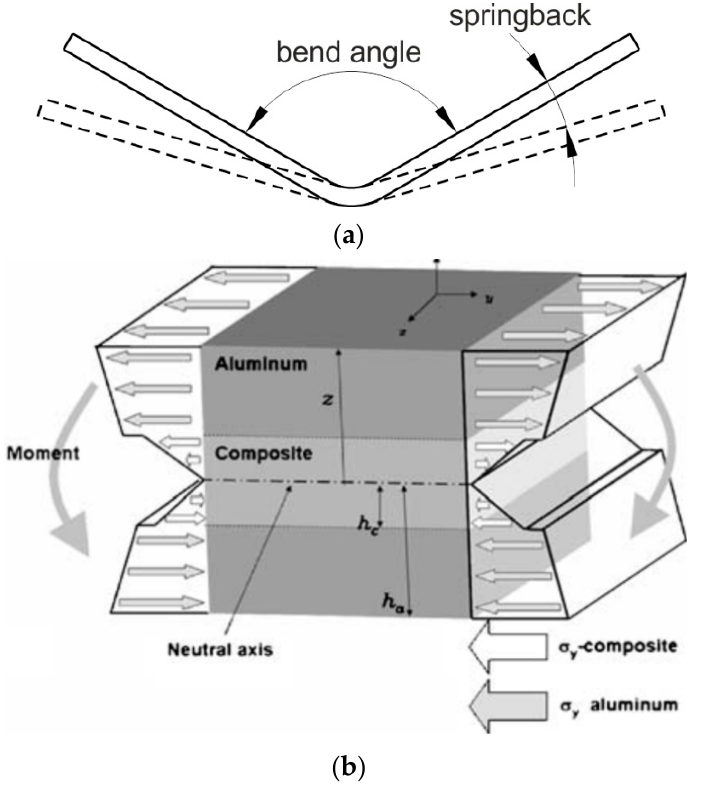
Figure 8. ( a ) The springback phenomenon and ( b ) the stress state in the bending of GLARE (reprinted with permission from [173]; copyright© 2021, Springer ‐ Verlag London Limited).